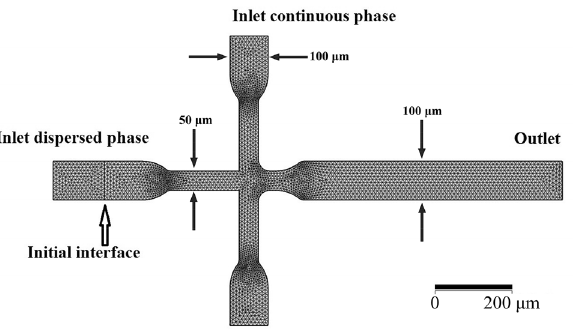
Figure 1. The pattern of the MFFD applied in simulations: meshes and boundaries situations specified for the microfluidic droplet generatrix in the two-dimensions